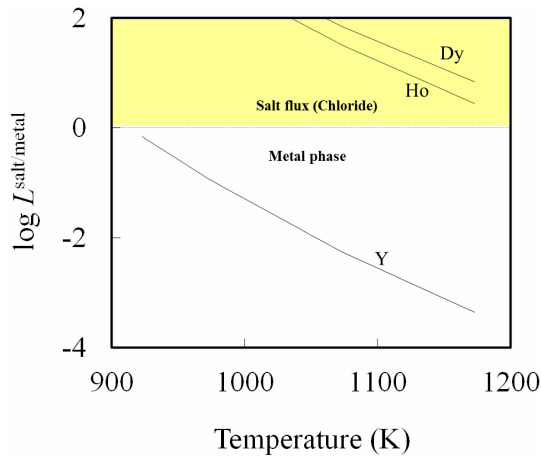
Figure 5. Temperature dependence of element distributions (elements: Dy, Ho and Y) between metal and chloride phase for flux A.